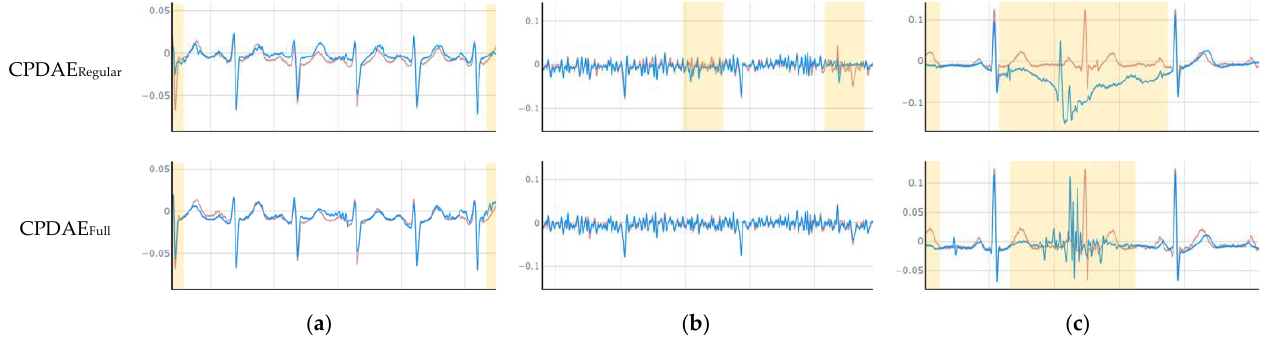
Figure 18. Three scenarios for the limitations of the proposed CPDAE algorithm. ( a ) Boundary effect; ( b ) high-frequency interference; ( c ) strong high-frequency noise interference with boundary effect.